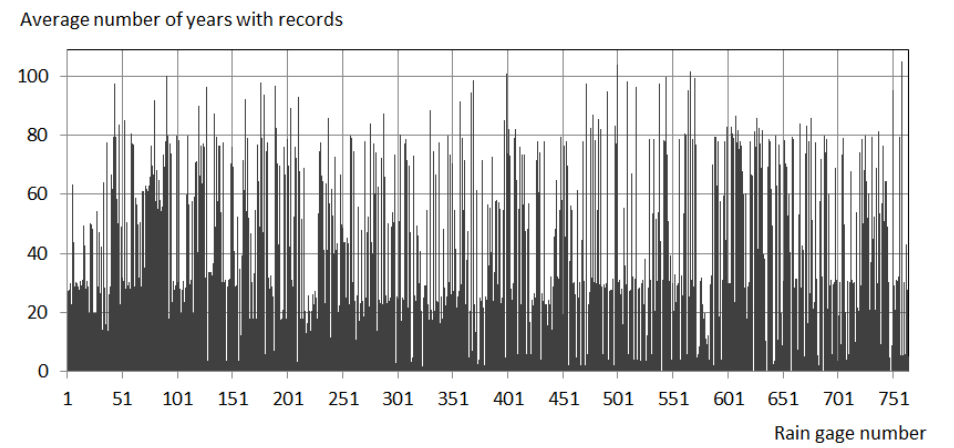
Figure 3. SNIRH database [44]. Average number of years per rain gauge with monthly records, from October 1910 to September